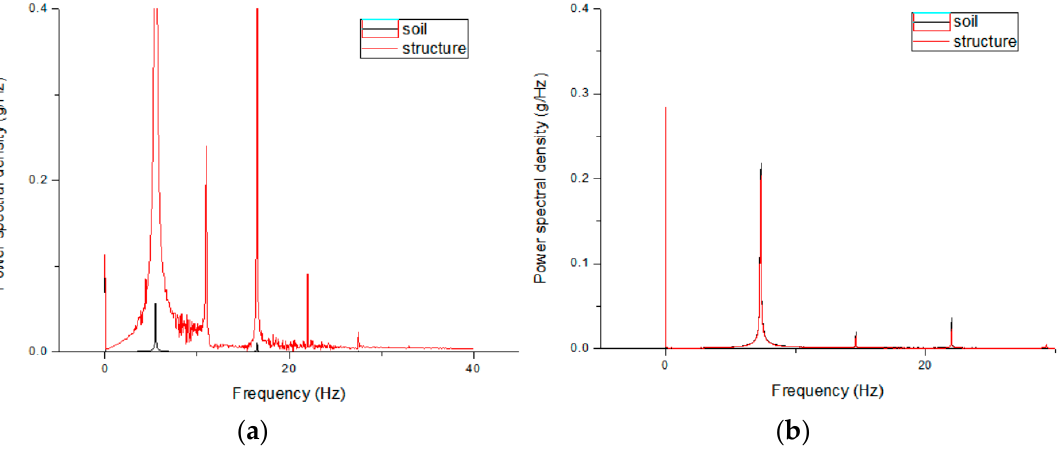
Figure 16. Relative Acceleration Auto-power Spectrum Density curves at Soil-Pile Interface: ( a ) S5-1, ( b ) S10. In addition, the system is a classical damping system as soon as the relative motion states between soil and pile satisfy the Equation (29), otherwise the system is a non-classical damping system. The coupling strength of motion states at the interaction interface is .. u ( i ) judged by the changing regularity of relative motion characteristics at the interface of . u ( i ) soil and pile in the time domain. The difference function of the ratio of relative acceleration .. u ( 1 ) .. u ( 2 ) − ) is chosen as the research object for comparison purposes and relative velocity ( . u ( 1 ) . u ( 2 ) and the result is shown as Figure 17. Red dots represent the difference function of motion states on condition S10 and black dots represent condition S5 in Figure 17. We can see that red dots stay close to zero as time goes on, which means relatively synthetic motion states of two groups of measuring points always satisfy Equation (29), on the contrast, the high discreteness of black dots shows the un-coordination of relatively synthetic motion states at the same interface. According to the analysis conclusion in Section 4.2, motion states at the soil-structure interface stays consistent in condition S10 and the system can be treated as a classical damping system. Conversely, the condition S5 is non-classical damping because the relative synthetic motion states on soil-structure interface cannot be coordinated and